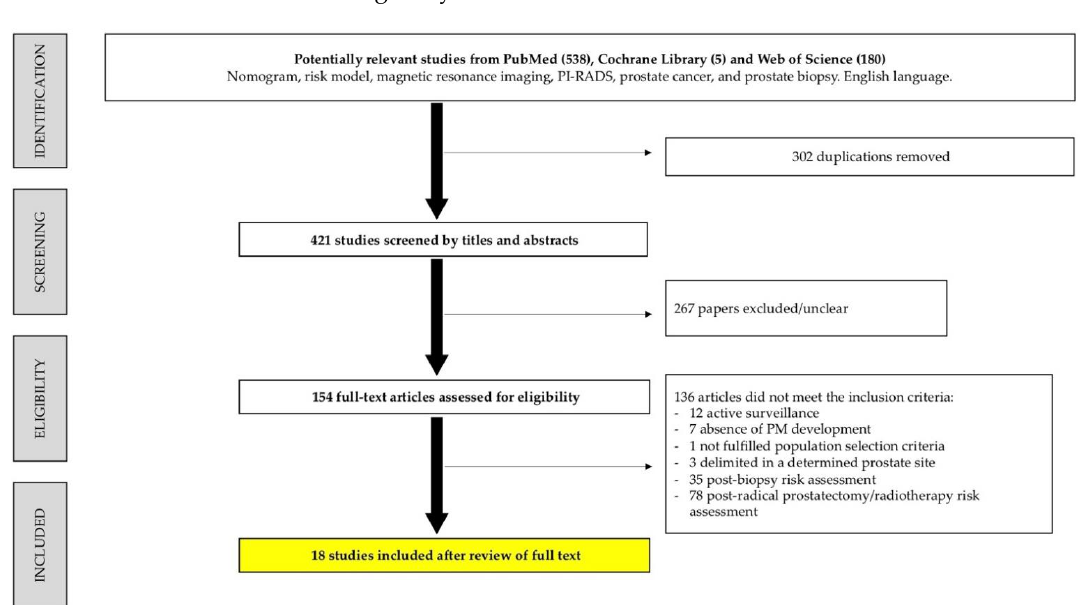
Figure 1. Flow chart of systematic review according to the PRISMA criteria .